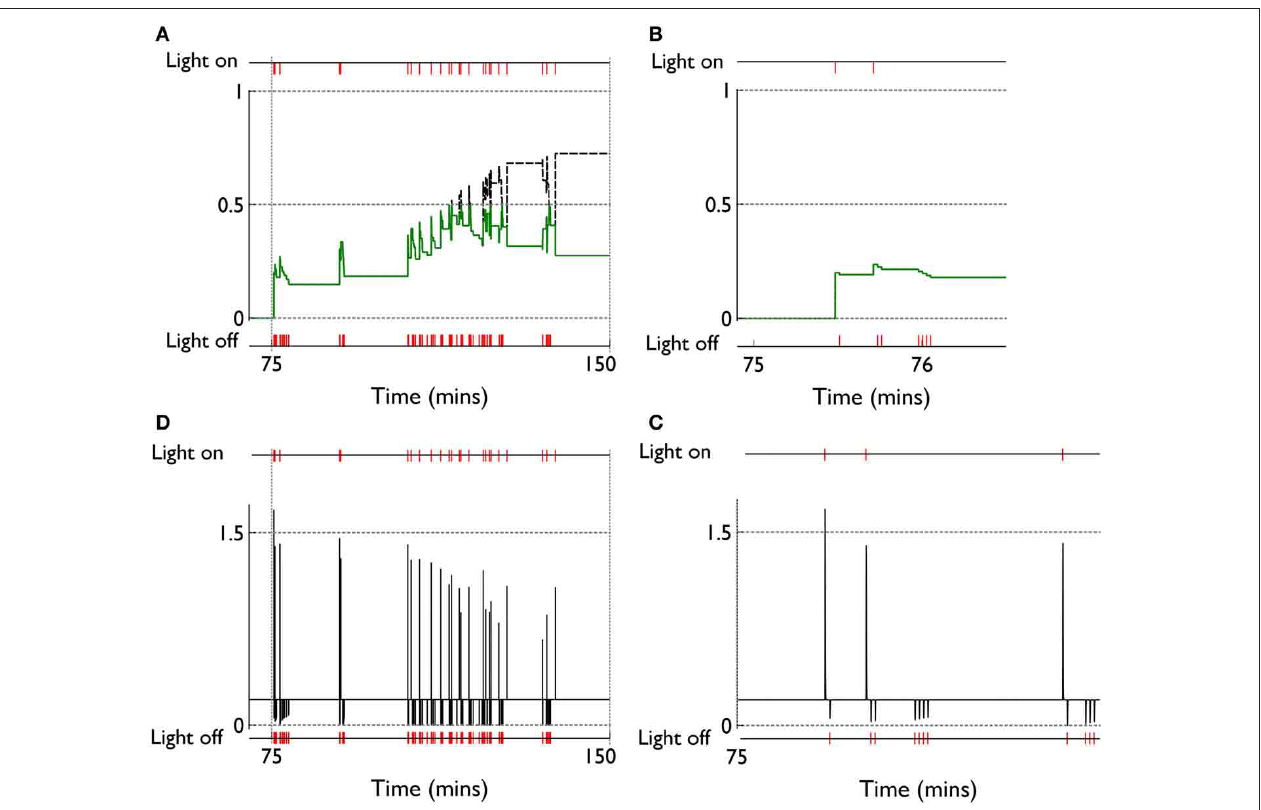
FIGURE 11 | Signals governing learning in pDA models with novelty salience and prediction, undergoing variable interval training. (A) Shows the novelty salience (solid green line) and prediction signal (dashed black line) during the response contingent (RC) phase in a similar way to that used in